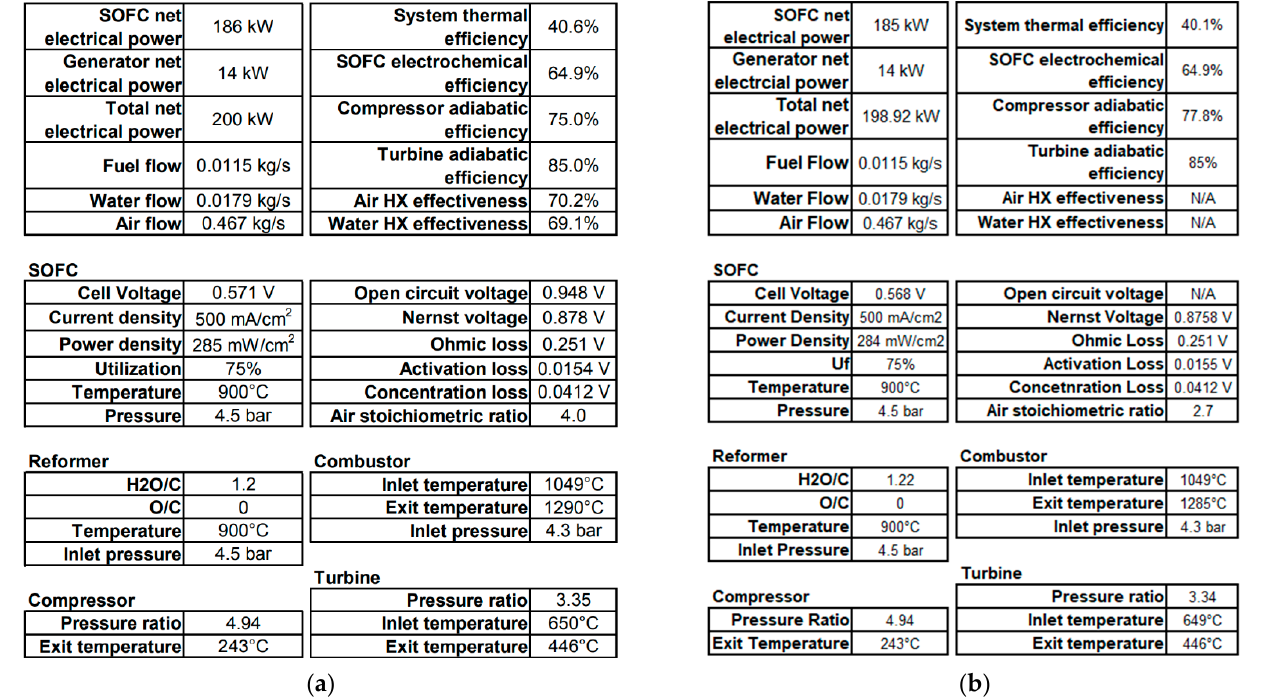
Figure 6. NASA’s NPSS SOFC/GT hybrid system architecture [12].